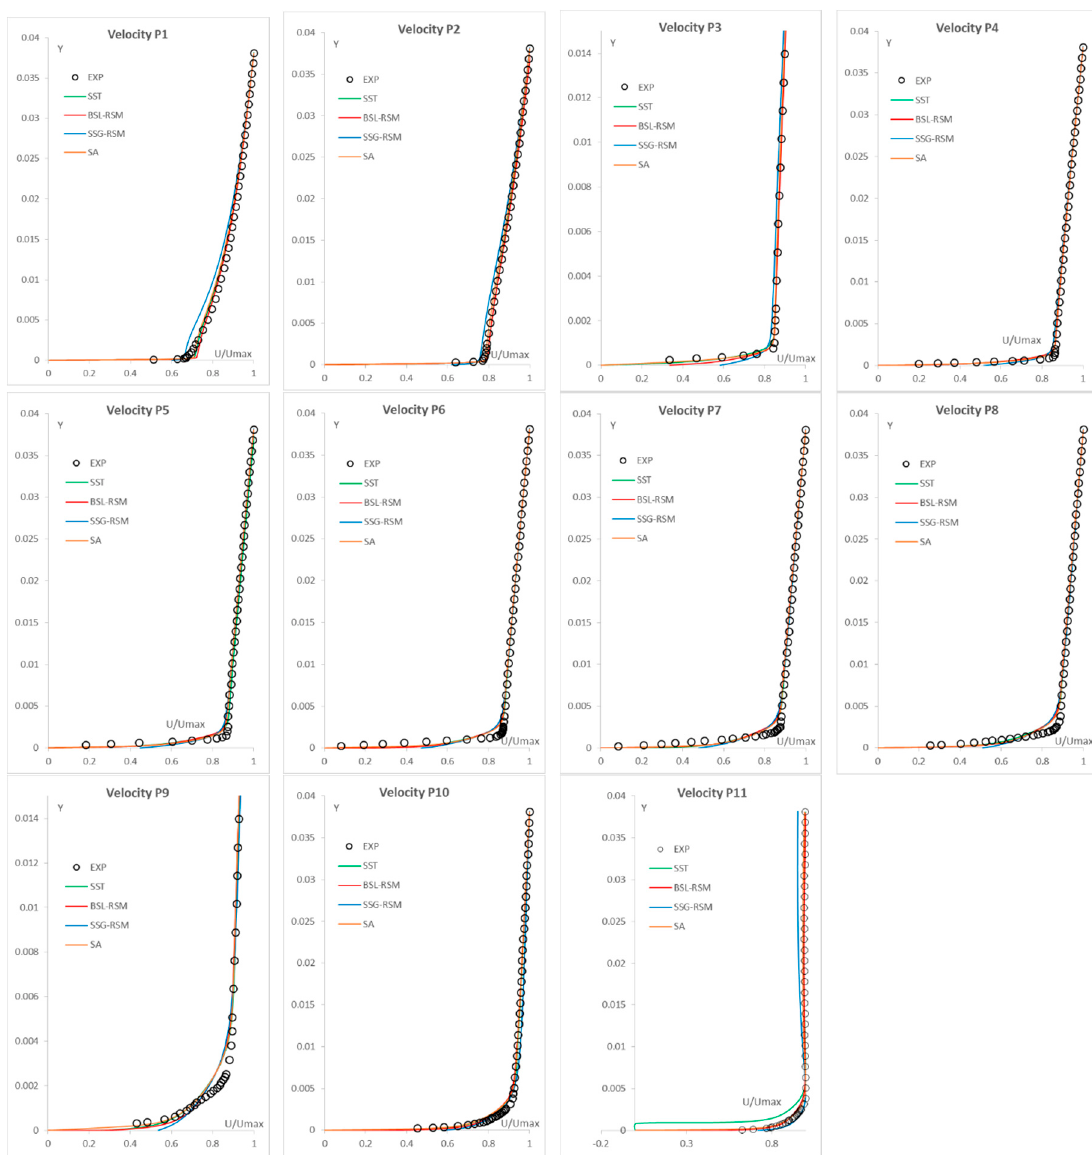
Figure 5. Velocity distributions on the DCA pressure side.